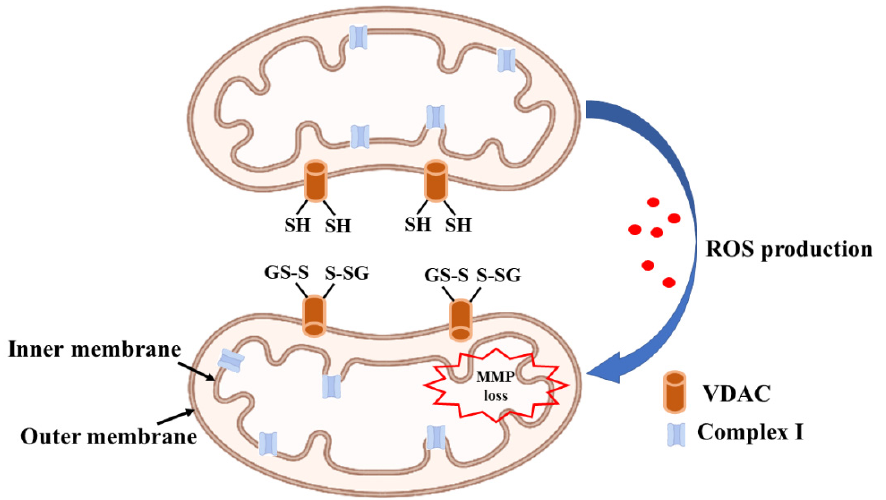
Figure 4. Oxidative stress leads to complex I inhibition and mitochondrial membrane potential loss. Protein thiols present in VDAC undergo oxidation leading to increased permeability of transition pore and loss of mitochondrial membrane potential. MMP loss facilitates the release of apoptotic factors such as cytochrome c promoting cell death.